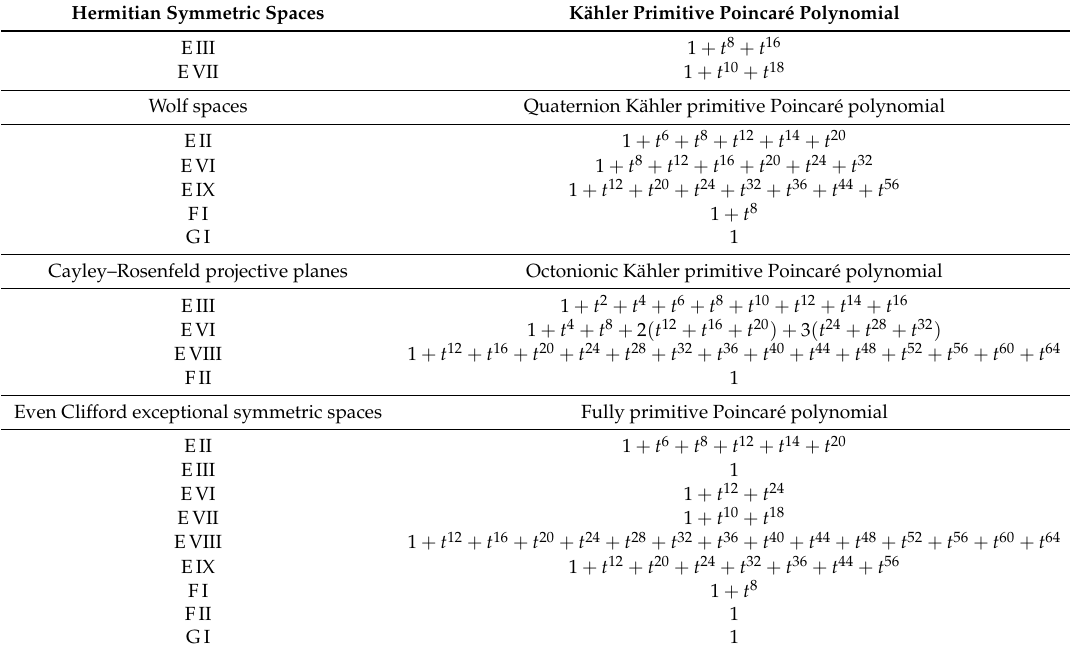
Table 7. Primitive Poincaré polynomials, (cid:101) P ( t ) = ∑ i = 0,... (cid:101) b i t i